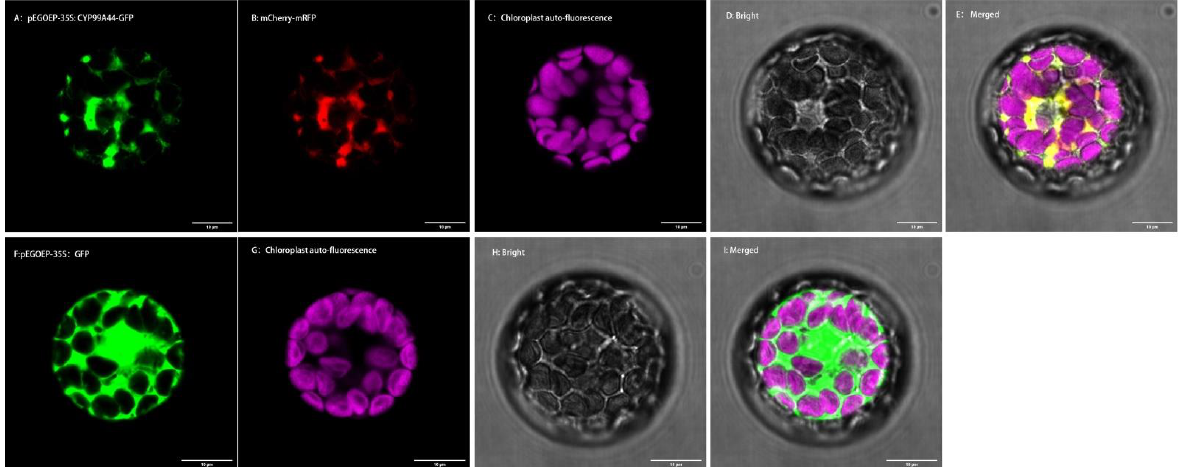
Figure 7. Subcellular localization of CYP99A44 . ( A ): pEGOEP-35S: CYP99A44 -GFP shown in green; ( B ): endoplasmic reticulum (ER) marker mCherry-mRFP shown in red; ( C ): chloroplast auto-fluorescence; ( D ): the bright-field; € : merged images; ( F ): pEGOEP-35S: GFP shown in green; ( G ): endoplasmic reticulum (ER) marker mCherry-mRFP shown in red; ( H ): the bright-field; ( I ): merged images. Scale bars: 10 μm in ( A – I ).